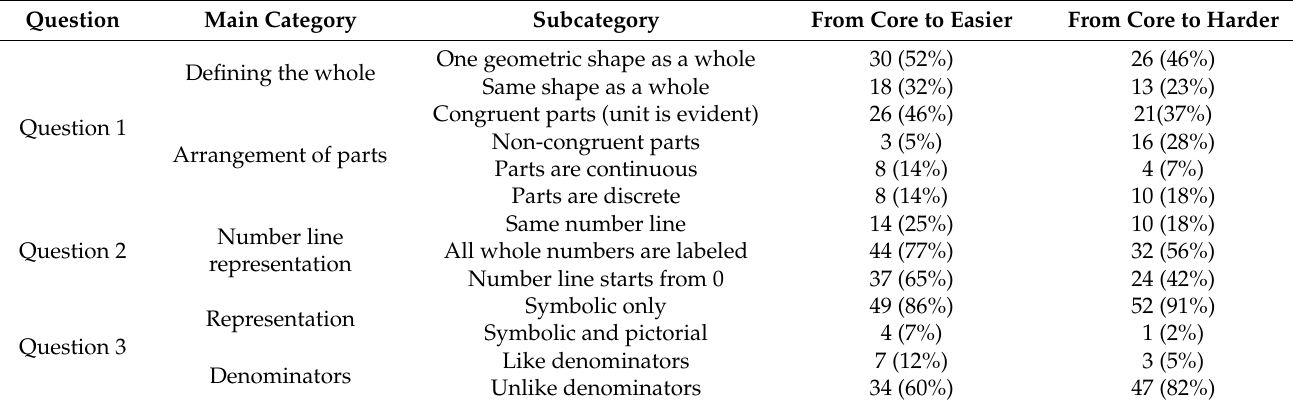
Table 4. Maintained aspects for Questions 1, 2, and 3.